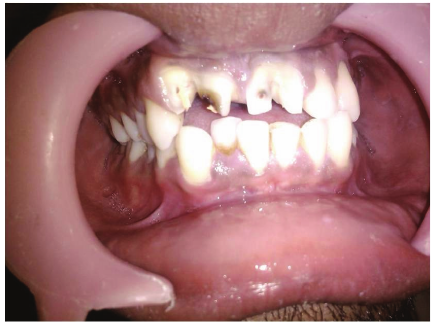
Figure 5: Clinical photograph of split crowns.